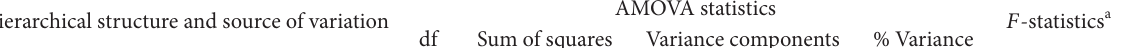
Table 4: Analysis of molecular variance (AMOVA) of Orobanche cumana populations from Bulgaria. Hierarchical structure and source of variation